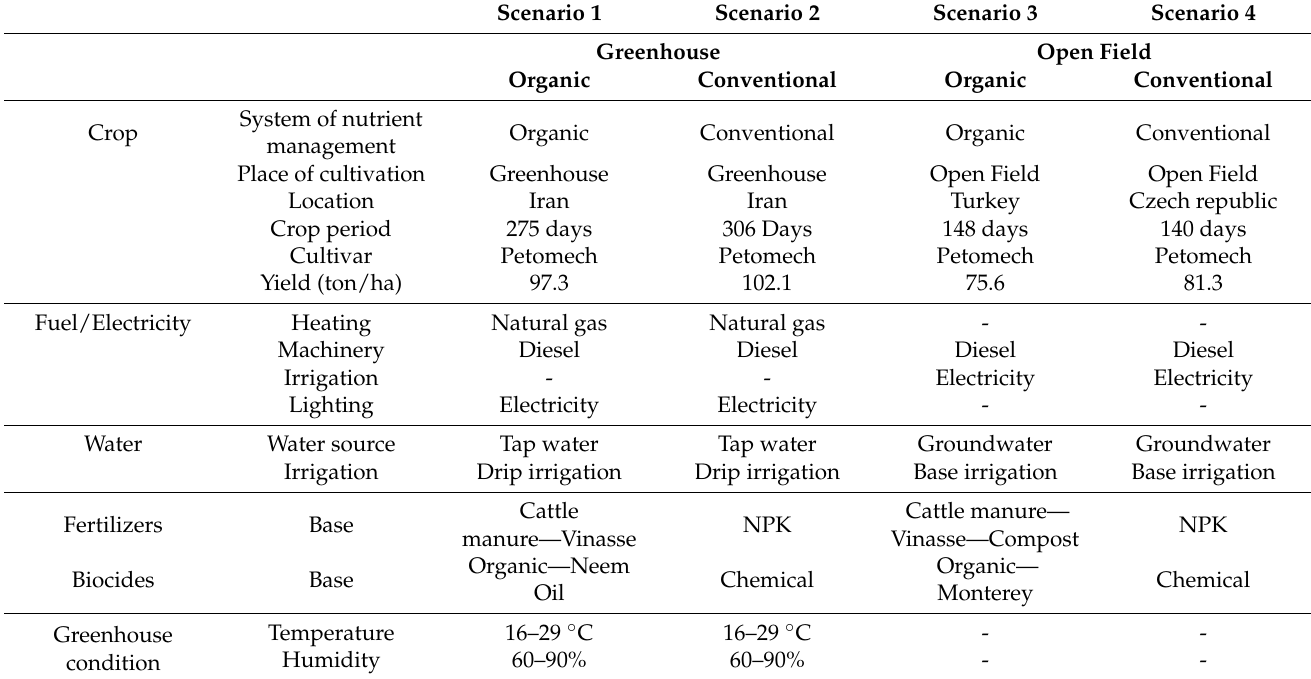
Table 1. Fundamental properties of the production system considered in the